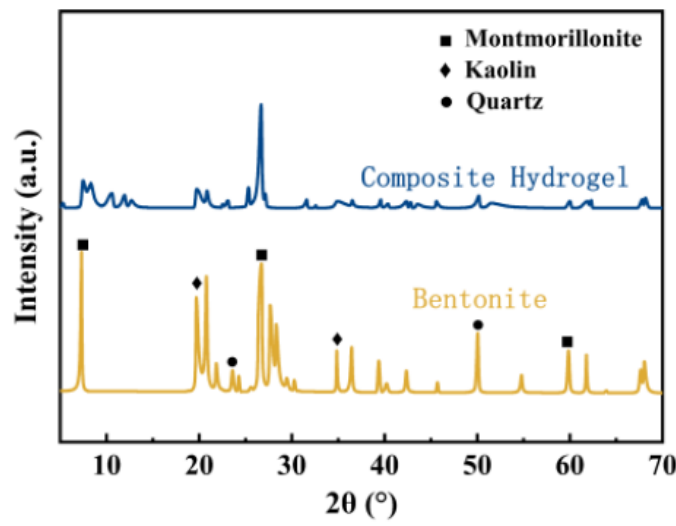
Figure 4. XRD patterns of bentonite and CTS/CA/BT composite hydrogel.